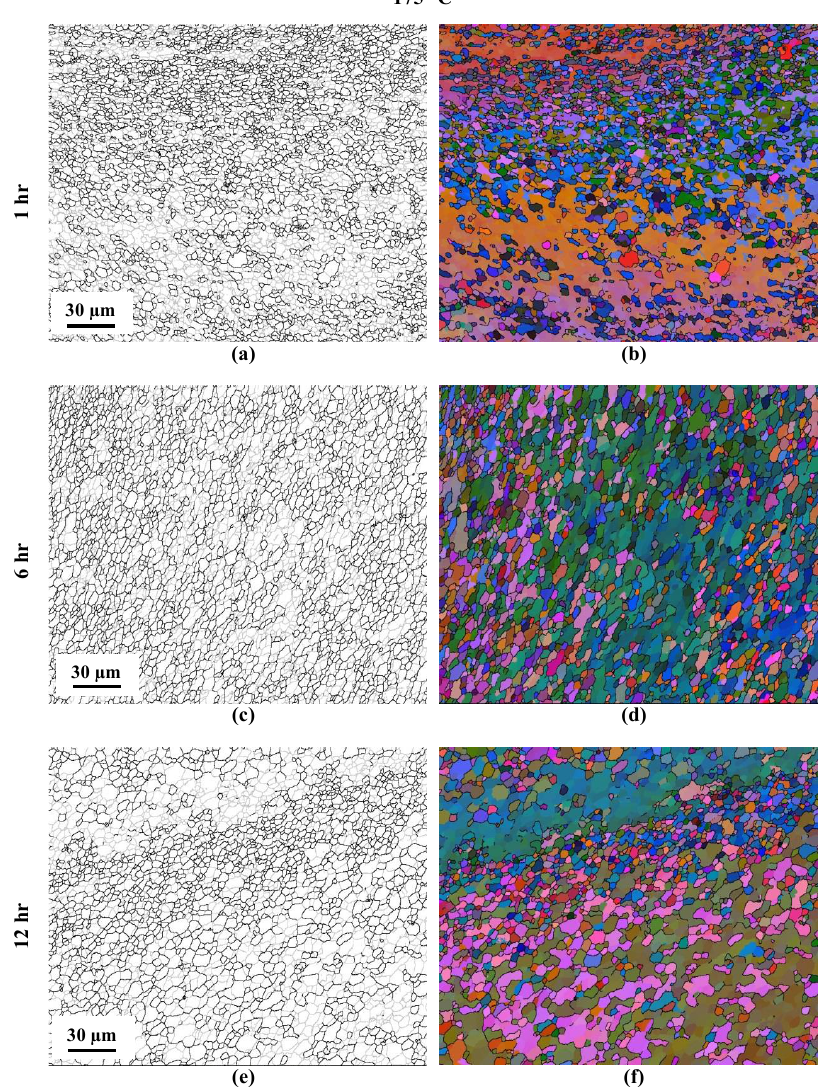
Figure 6. EBSD Grain boundary reconstruction maps and corresponding Euler maps of FSP AA6082 artificially aged at 175 °C for: ( a , b ), 1 h; ( c , d ) 6 h and ( e , f ) 12 h.